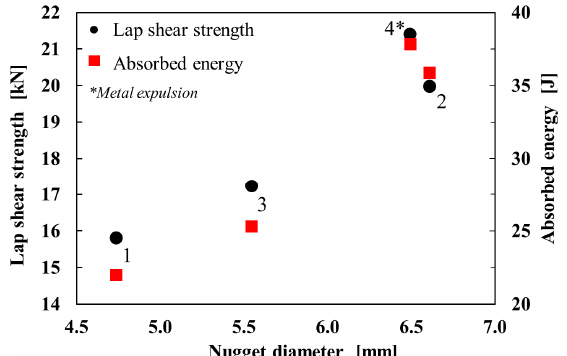
Figure 6. Average lap shear strength and absorbed energy of Q&P/TRIP spot welds for the different welding conditions.